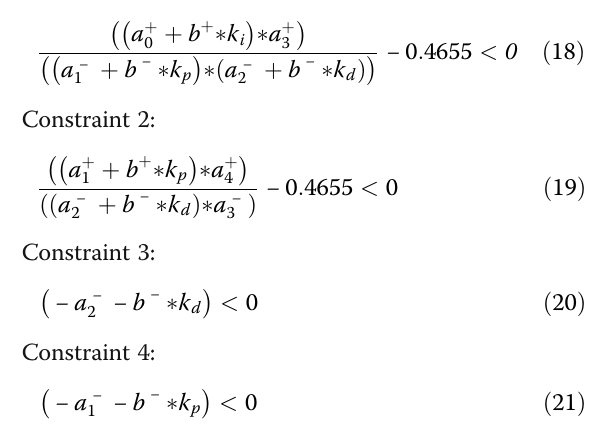
Fig. 4 Block diagram of